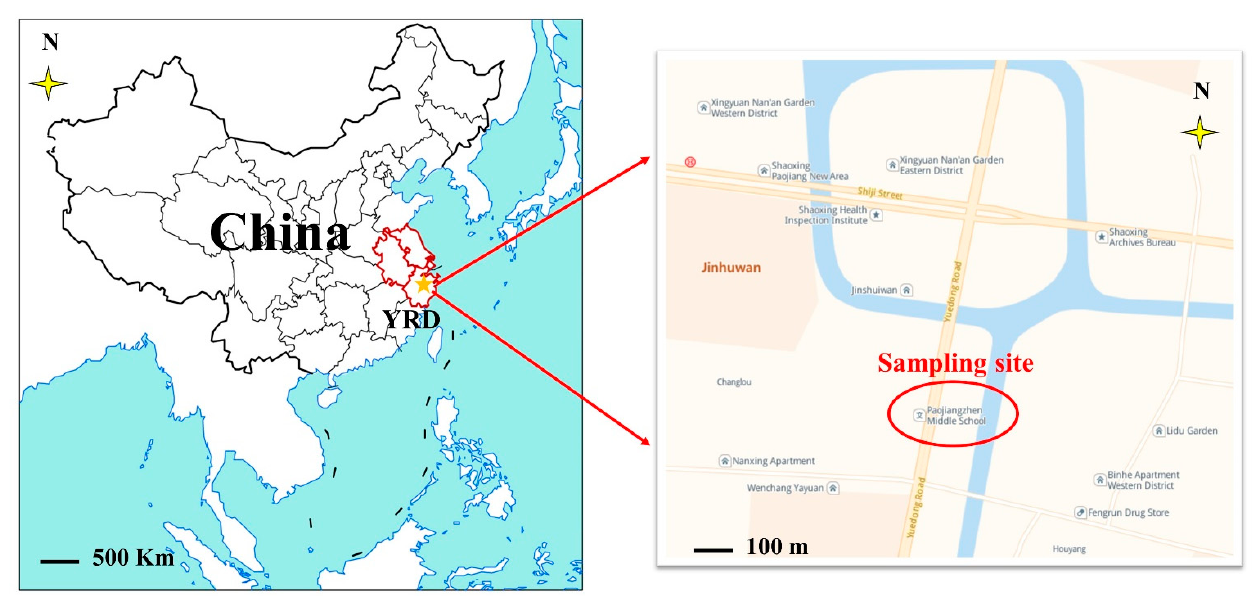
Figure 1. The sampling site in Yangtze River Delta (YRD) in China (left) and the location of the sampling site in Shaoxing city (right).